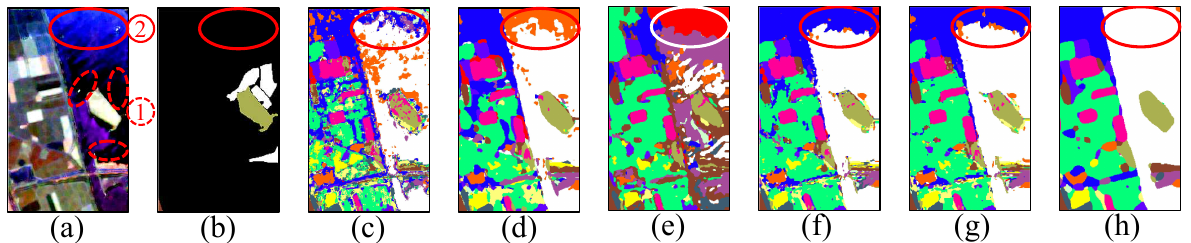
Figure 10. Enlarged results of the Water region on AIRSAR Flevoland dataset. ( a ) Pauli image. ( b ) Ground truth map. ( c ) 1D-CNN. ( d ) 2D-CNN. ( e ) DenseNet. ( f ) CapsNet. ( g ) CapsNet-3. ( h ) Proposed